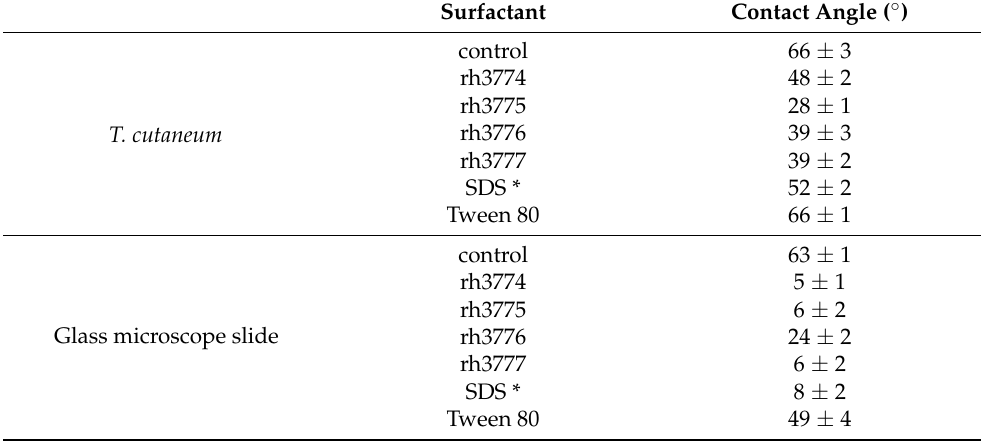
Table 3. The effect of surfactants at their critical micelle concentration on hydrophobicity of T. cu- taneum cells and glass microscope slides determined as values of water contact angles. Control represents cells or slide without treatment. Surfactant Contact Angle ( ◦ ) control 66 ± 3 rh3774 48 ± 2 rh3775 28 ± 1 rh3776 T. cutaneum rh3777 SDS * 52 ± 2 Tween 80 66 ± 1 control 63 ± 1 rh3774 5 ± 1 rh3775 6 ± 2 Glass microscope slide rh3776 24 ± 2 rh3777 6 ± 2 SDS * 8 ± 2 Tween 80 49 ±